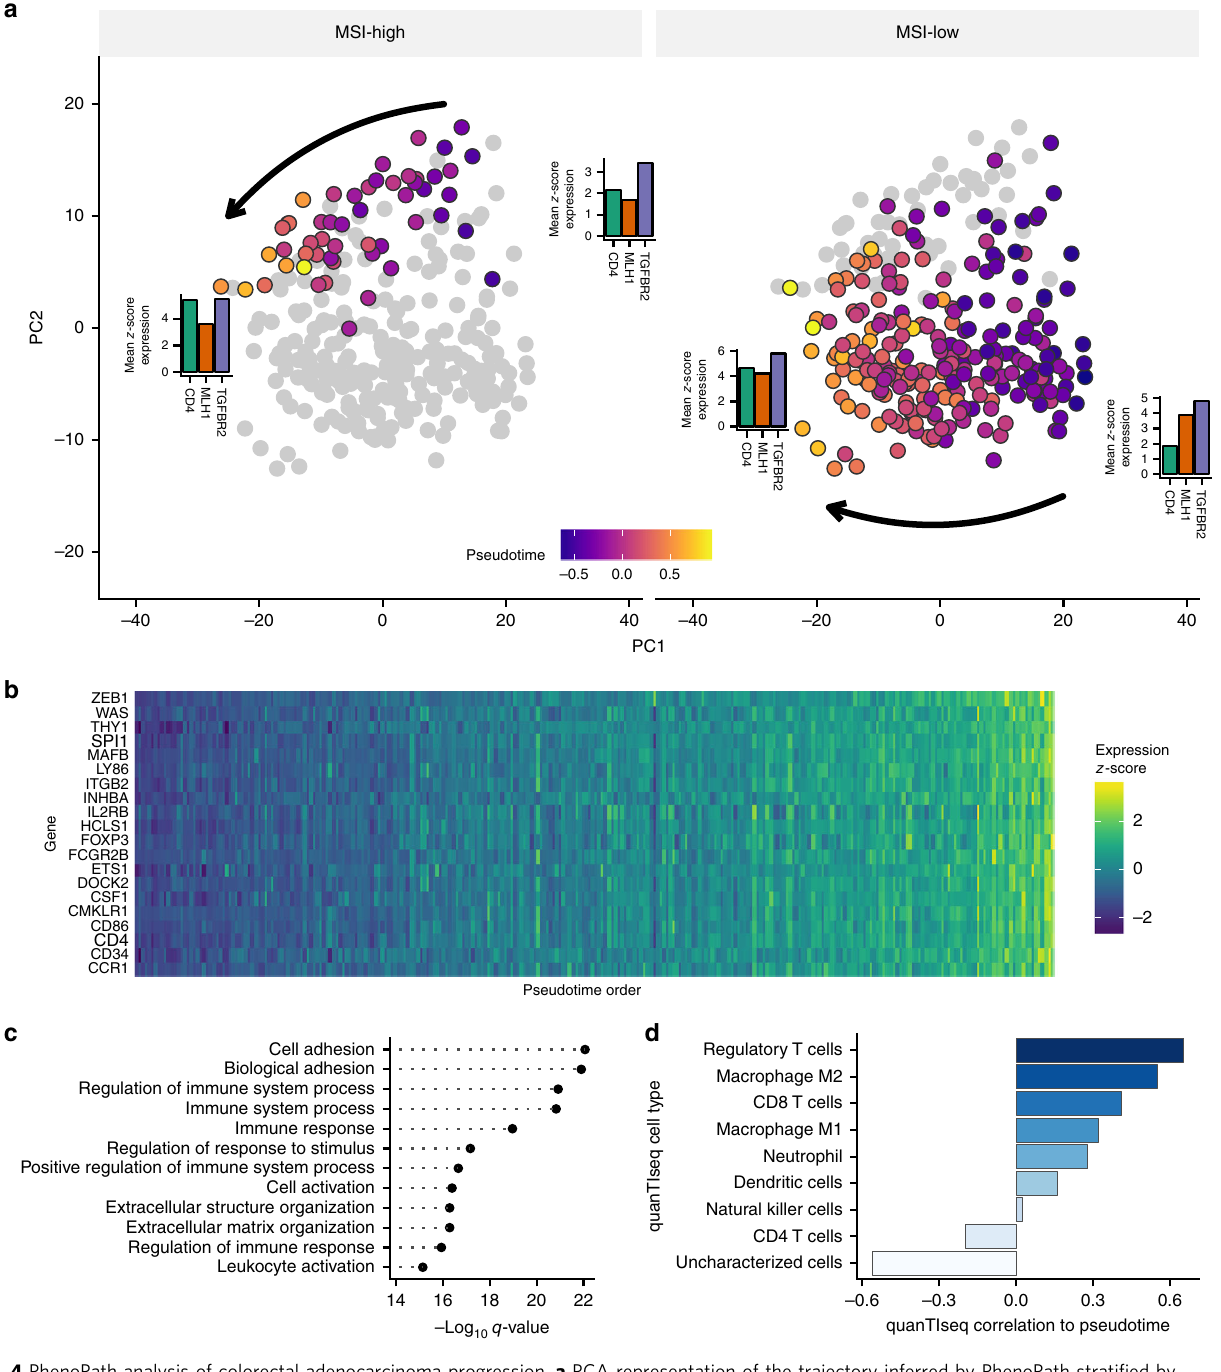
Fig. 4 PhenoPath analysis of colorectal adenocarcinoma progression. a PCA representation of the trajectory inferred by PhenoPath strati fi ed by microsatellite instability status. b Heatmap of expression of immune response genes shows upregulation over pseudotime. c A GO enrichment analysis of upregulated genes con fi rms the latent trajectory encodes immune pathway activation in each tumour. d Correlation of quanTIseq tumour immune content to PhenoPath